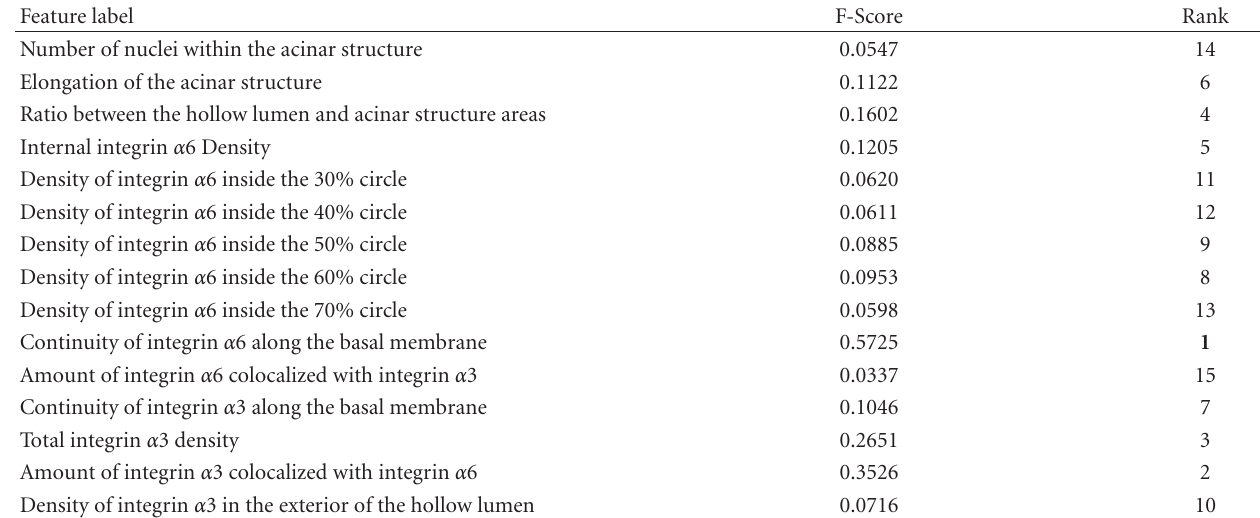
Table 2: Discriminative influence of the proposed features based on the F-score values.